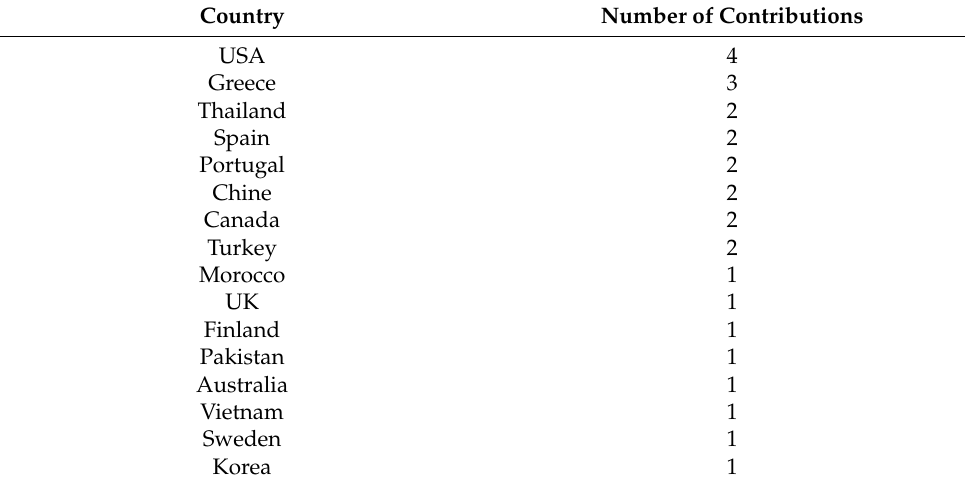
Table 3. Number of contributions per country. Country Number of